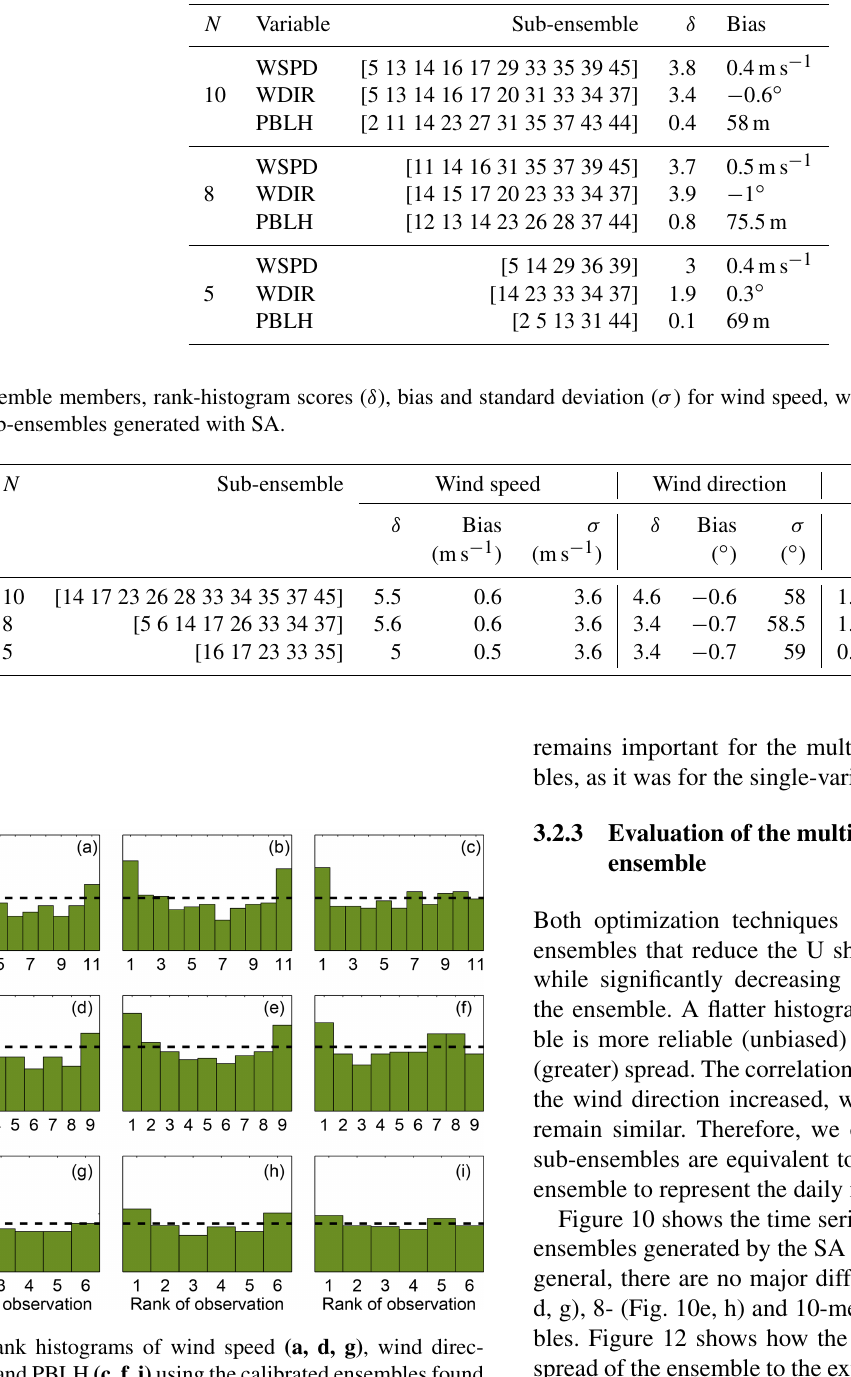
Table 3. Calibrated ensembles generated by both SA and GA and their rank-histogram scores and bias for each variable.